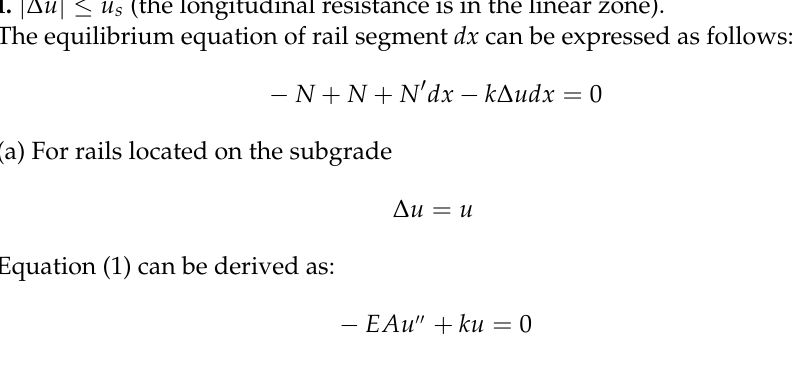
Figure 3. Bilinear model of longitudinal resistance. I. | ∆ u | ≤ u s (the longitudinal resistance is in the linear